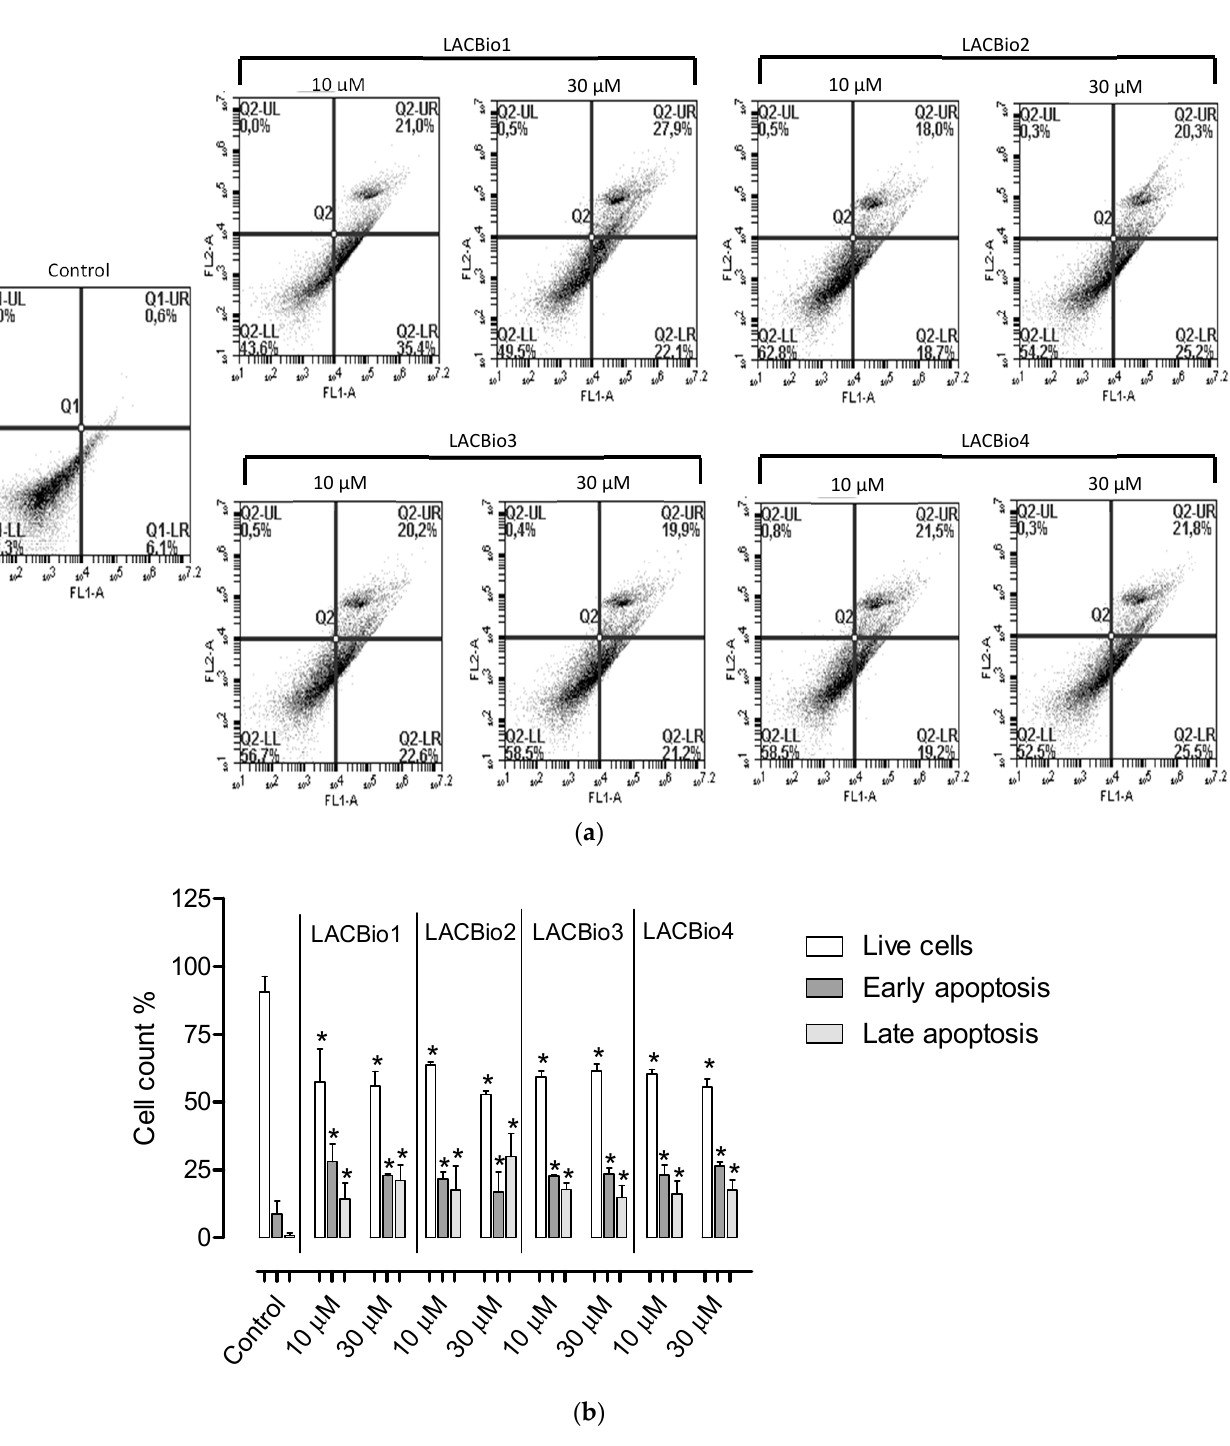
Figure 1. LACBio1, LACBio2, LACBio3 and LACBio4 triggered apoptosis in MDA-MB 231 cells. Cells were treated with compounds for 24 h. Representative data from the fluorescence-activated cell sorting (FACS) analysis are shown in ( a ), and the cell count (in %) of the data obtained from the FACS analysis is shown in ( b ). All the values are presented as the mean ± standard error of three independent experiments. Statistical analyses were performed using GraphPad Prism 8.02 and included one-way ANOVA with Dunnett’s post hoc test, and statistical significance was defined as * p < 0.05 when compared with the control group.